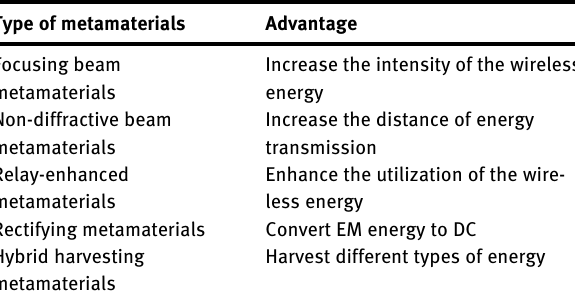
Table  : The advantages of metamaterials for WPT and WEH. Type of metamaterials